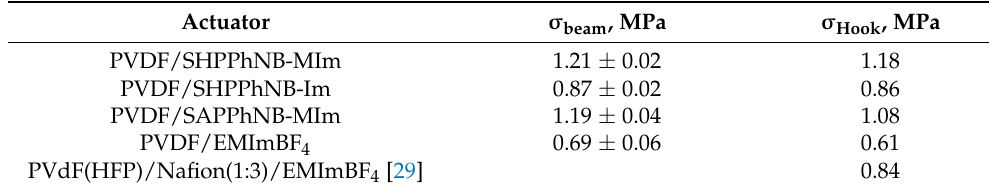
Table 6. Strain values calculated from peak-to-peak displacement and specific power consumption of the actuators under 2 and 3 V at 0.1 Hz.